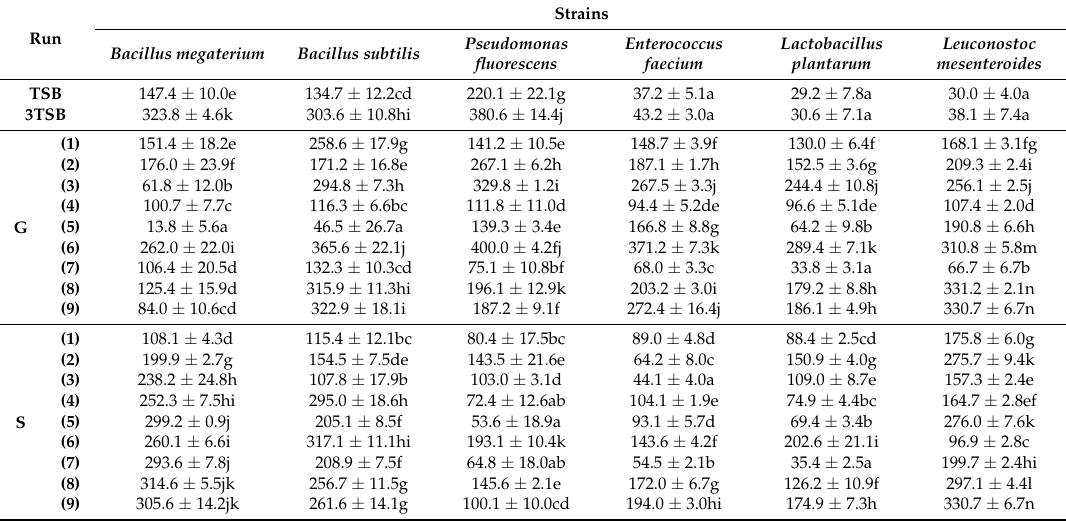
Table 2. Maximum scatter light values for bacterial strains at Taguchi’s experiment.